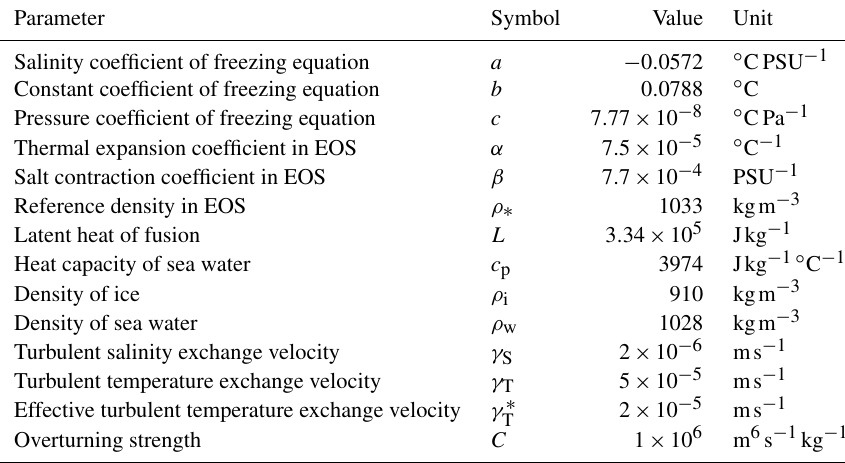
Table 1. PICO parameters and typical values. Parameter Symbol Value Unit Salinity coefficient of freezing equation a − 0 . 0572 ◦ CPSU − 1 Constant coefficient of freezing equation b 0 . 0788 ◦ C Pressure coefficient of freezing equation c 7 . 77 × 10 − 8 ◦ CPa − 1 Thermal expansion coefficient in EOS α 7 . 5 × 10 − 5 ◦ C − 1 Salt contraction coefficient in EOS β 7 . 7 × 10 − 4 PSU − 1 Reference density in EOS ρ ∗ 1033 kgm − 3 Latent heat of fusion L 3 . 34 × 10 5 Jkg − 1 Heat capacity of sea water c p 3974 Jkg − 1 ◦ C − 1 Density of ice ρ i 910 kgm − 3 Density of sea water ρ w 1028 kgm − 3 Turbulent salinity exchange velocity γ S 2 × 10 − 6 ms − 1 Turbulent temperature exchange velocity γ T 5 × 10 − 5 ms − 1 Effective turbulent temperature exchange velocity γ ∗ 2 × 10 − 5 ms − 1 T Overturning strength C 1 × 10 6 m 6 s − 1 kg − 1 The coefficients in the equation of state (EOS), the turbulent exchange velocities for heat and salt, are taken from Olbers and Hellmer (2010). We linearized the potential freezing temperature equation with a least-squares fit with salinity values over a range of 20–40 PSU and pressure values of 0– 10 7 Pa using Gibbs SeaWater Oceanographic Package of TEOS-10 (McDougall and Barker, 2011). All values are kept constant, except for γ ∗ T and C , which vary between experiments. The values of these two parameters are the best-fit from Sect. 3.1.